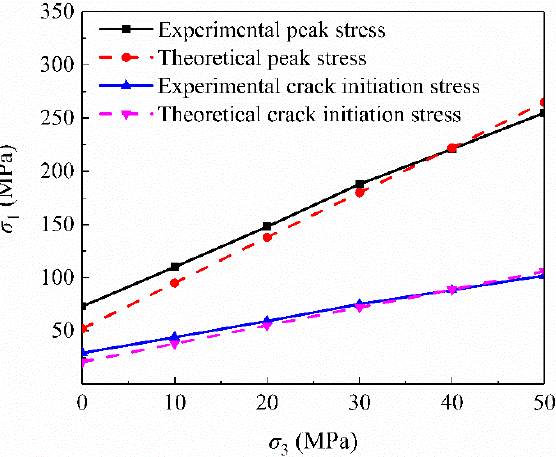
Figure 9. Relationships between crack initiation stress, peak stress and confining pressures in experimental and theoretical results.